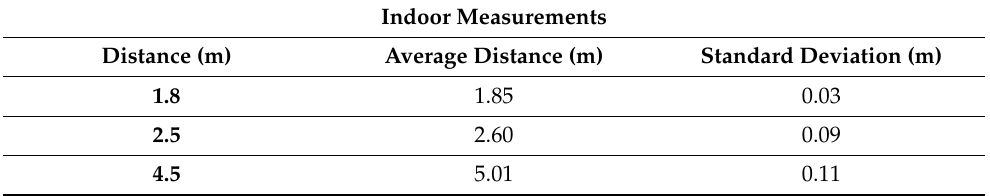
Table 3. Indoor detection effectiveness.